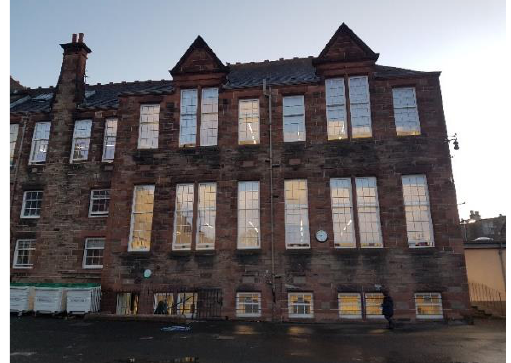
Figure 10. Picture of school C.